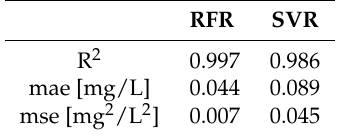
Figure 5. Offshore model relational plot for Support Vector Regression ( top ) with R 2 = 0.986, along with the residuals plot ( bottom ). Table 3. Offshore oxygen prediction errors results.